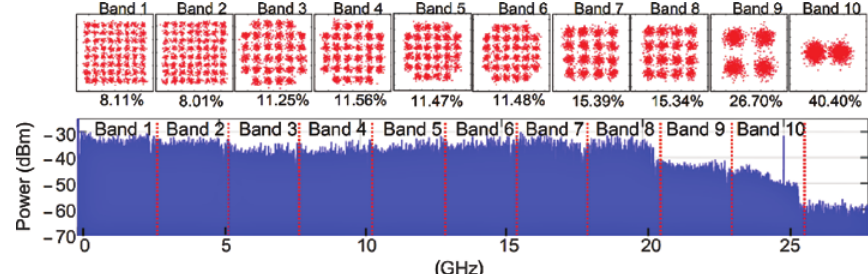
Figure 18: Received electrical spectrum and constellation diagrams for 107.5 Gb/s transmission over 100 m MMF